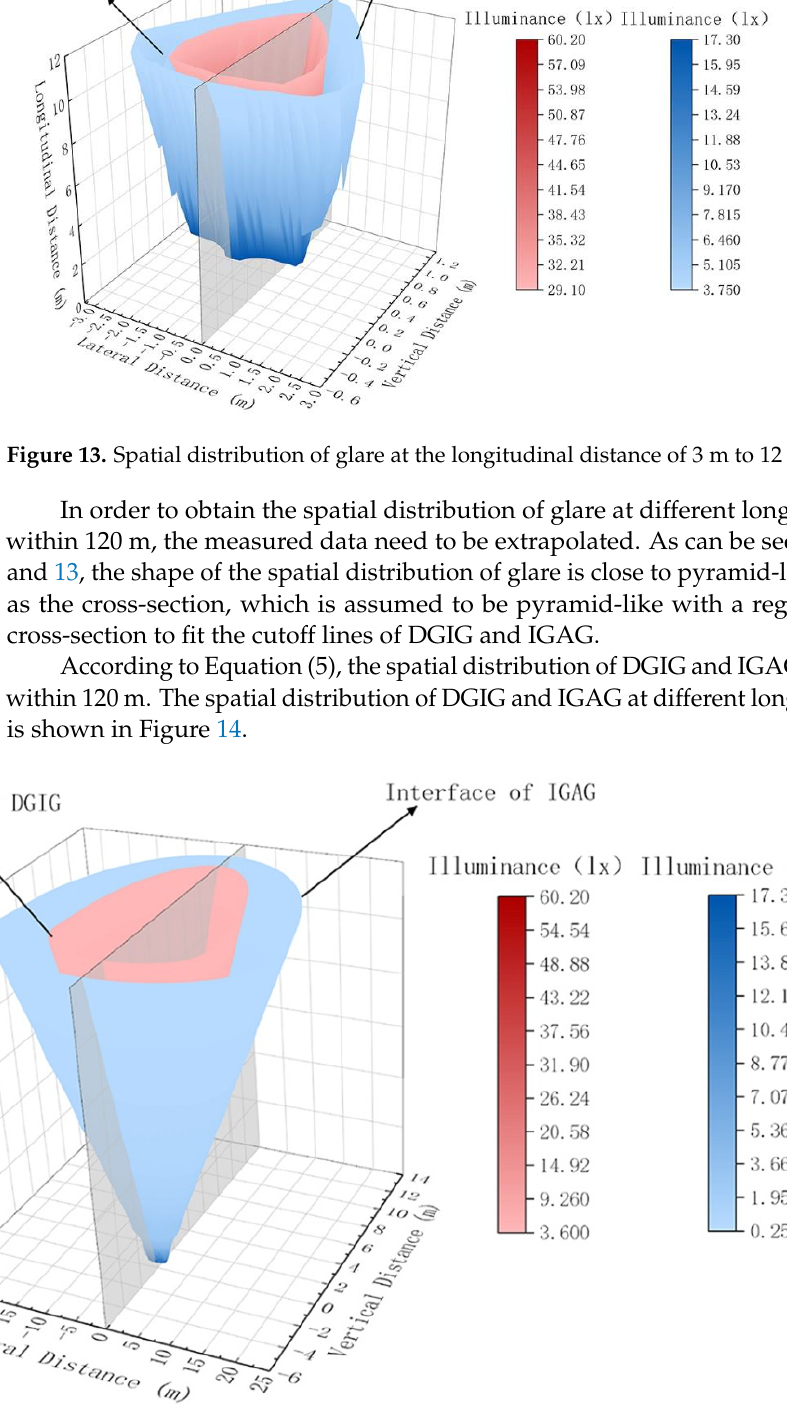
Figure 14. Spatial distribution of DGIG and IGAG at different longitudinal distances within 120 m.